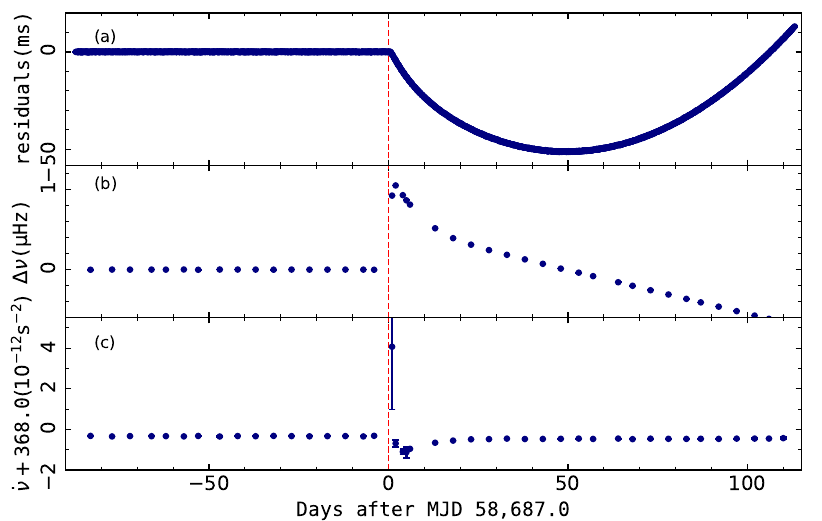
Figure 6. The simulated July 2019 Crab delayed spin-up behaviour as presented by Shaw et al. [75]: ( a ) timing residuals relative to a pre-glitch spin-down model; ( b ) the time-dependence of the frequency residuals ∆ ν ; ( c ) the evolution of spin-down rate ˙ ν . The vertical line signifies the glitch around MJD